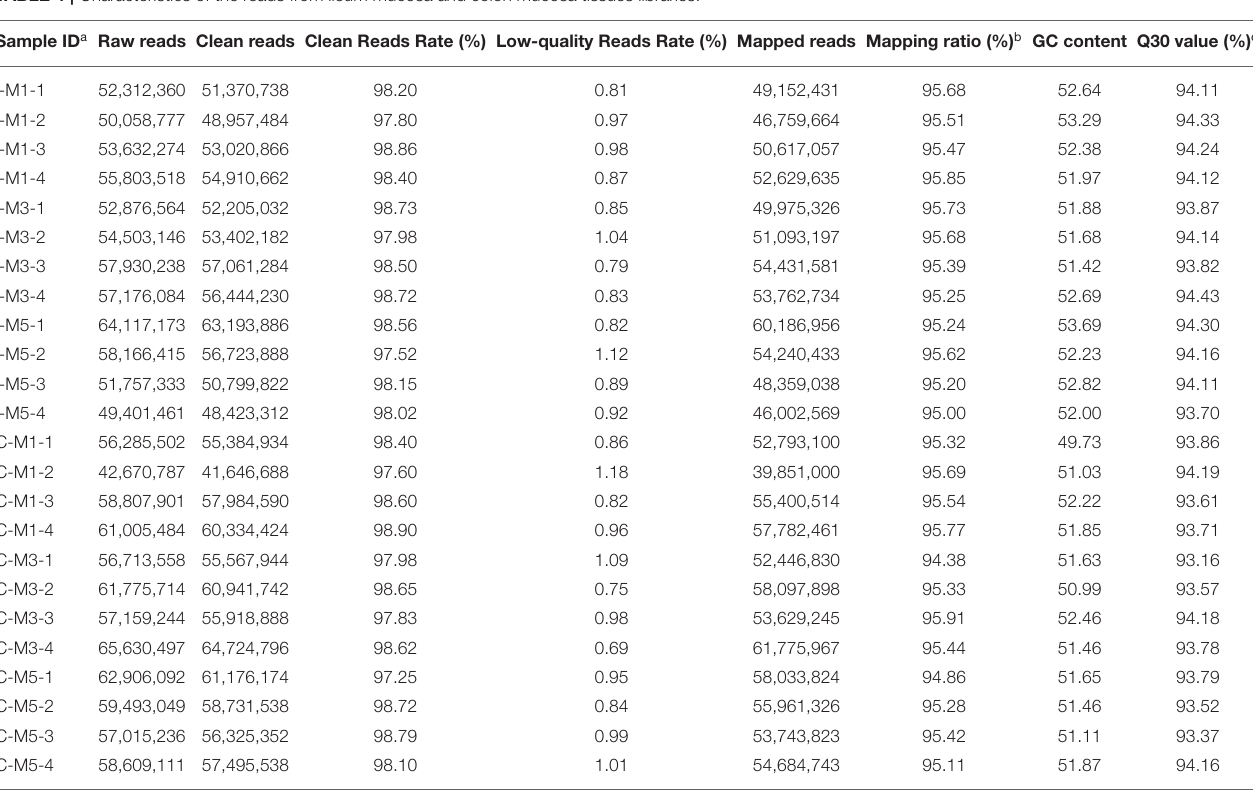
TABLE 4 | Characteristics of the reads from ileum mucosa and colon mucosa tissues